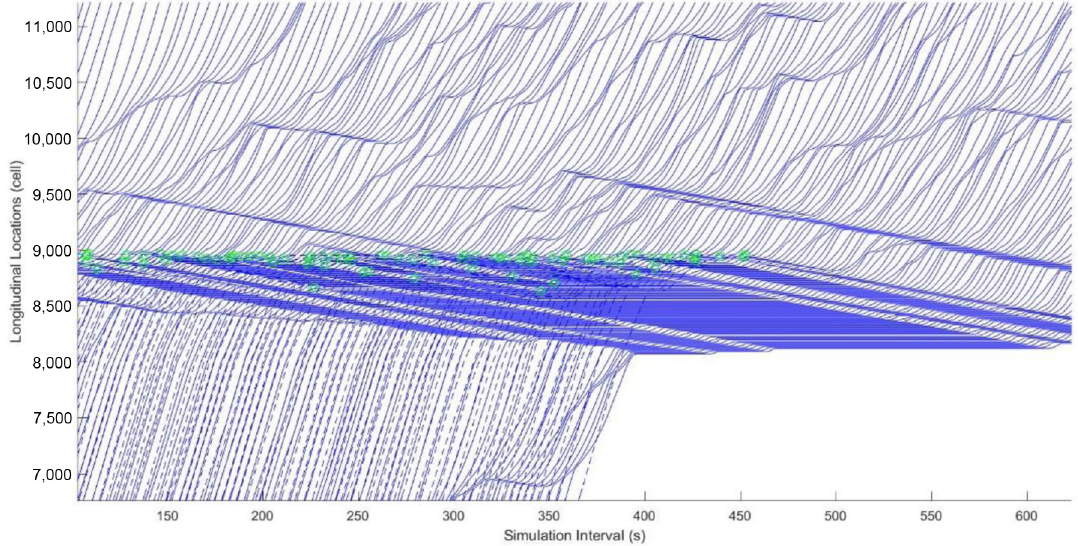
Figure 7 Trajectories without CAV ’ s